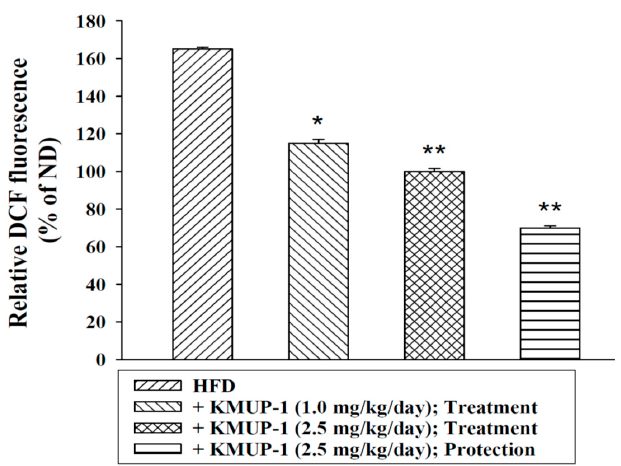
Figure 6. The levels of hepatic ROS was reduced by treating KMUP-1 (1, 2.5 mg/kg/day). HFD induced accumulation of ROS in livers. Protection/treatment with KMUP-1 for 6 weeks/14 weeks decreased the hepatic ROS. ROS was determined as described in Materials and Methods. Data are means ± S.E. of six independent experiments. * p < 0.05; ** p < 0.01 versus HFD group. ND: normal chow diet.